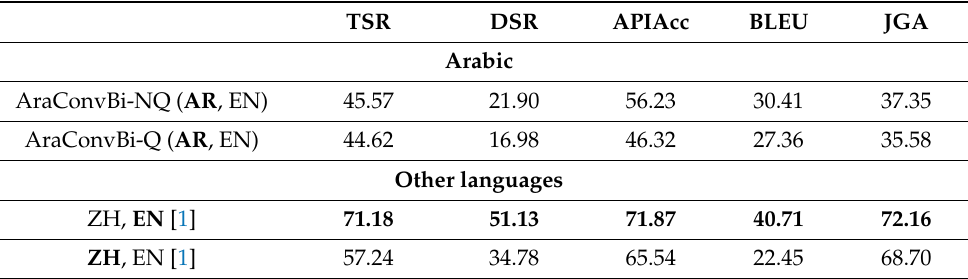
Table 5. Bi-lingual experiment DST and end-to-end dialogue generation results for the AraConv model trained on the Arabic-TOD dataset compared to the bi-lingual BiToD experiments [1] using English and Chinese BiToD datasets. The bold letters refer to the target language in the corresponding experiments (used to test the model). Bold numbers indicating the best result according to the column’s metric value.